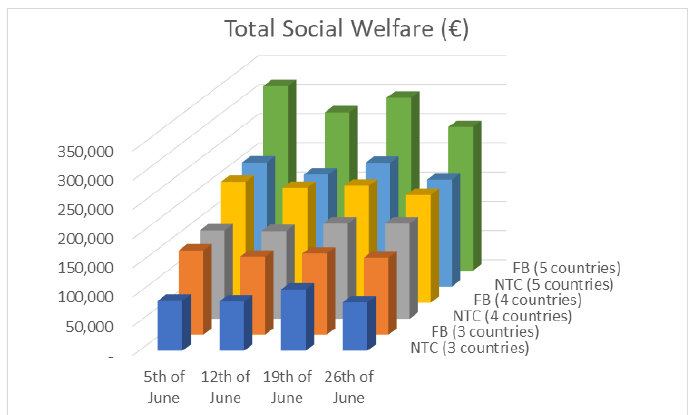
Figure 10. Total social welfare in euro via both approaches.